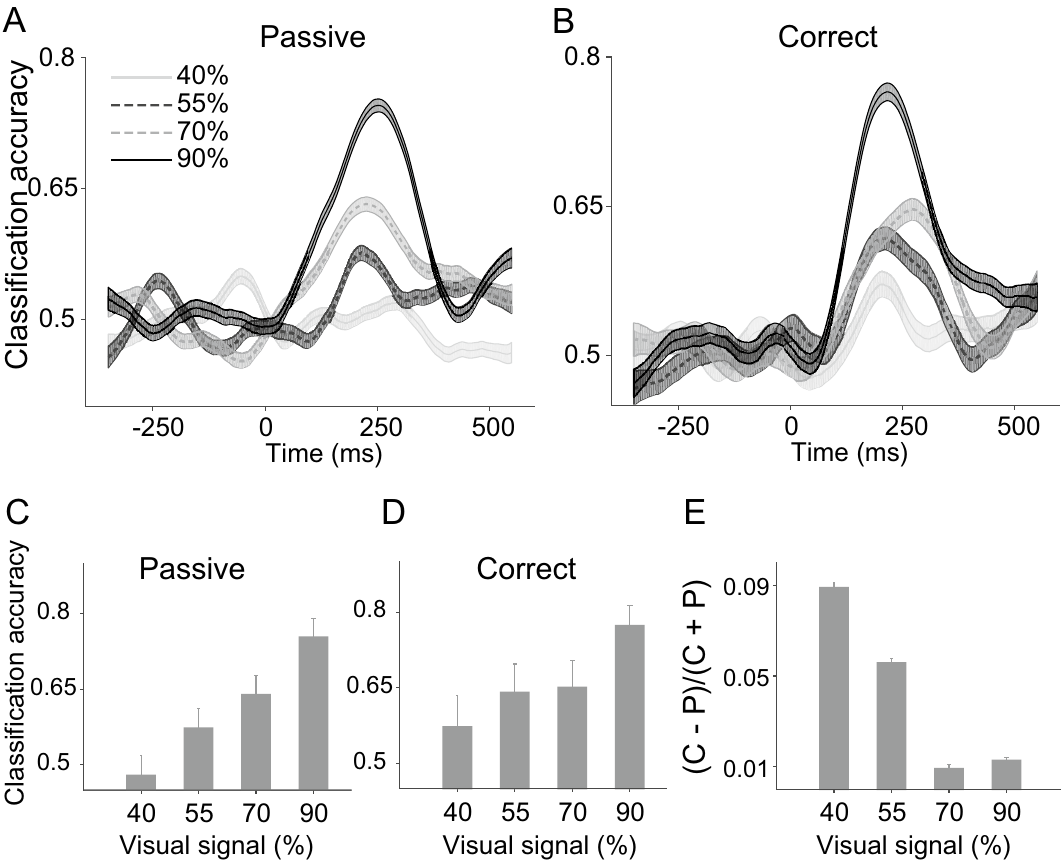
Figure 4. SVM classifier performance of body-selective neural population in different stimulus noise levels and task conditions. Time course of decoding accuracy in passive ( A ) and correct ( B ) trials in different signal levels. Data points are plotted in the middle of each bin. Bar graphs illustrate the classification accuracy during 150 to 350 ms after stimulus onset at different noise levels in passive ( A ) and correct ( B ) trials. ( E ) Classification performance in correct trials relative to passive trials. Error bars represent the STD of bootstrap passive (Fig. 5A; ΔCI body–nonbody : 40% = -0.08 ± 0.071, p = 0.884; 55% = 0.119 ± 0.086, p < 0.001; 70% = 0.251 ± 0.129, p < 0.001; 90% = 1.051 ± 0.235, p < 0.001) and correct (Fig. 5B; ΔCI body–nonbody : 40% = 0.179 ± 0.213, p < 0.05; 55% = 0.705 ± 0.267, p < 0.001; 70% = 0.505 ± 0.24, p < 0.001; 90% = 1.093 ± 0.27, p < 0.001) trials. Similar to the body selective neurons, non-body neurons’ category information was also enhanced during the categorization of the more noisy stimuli (Fig. 5C; Pearson correlation; r = −0.98, p < 0.05). Although there was no significant difference in response, spike count (SC) of body and non-body neurons to all stimuli in passive and active tri-